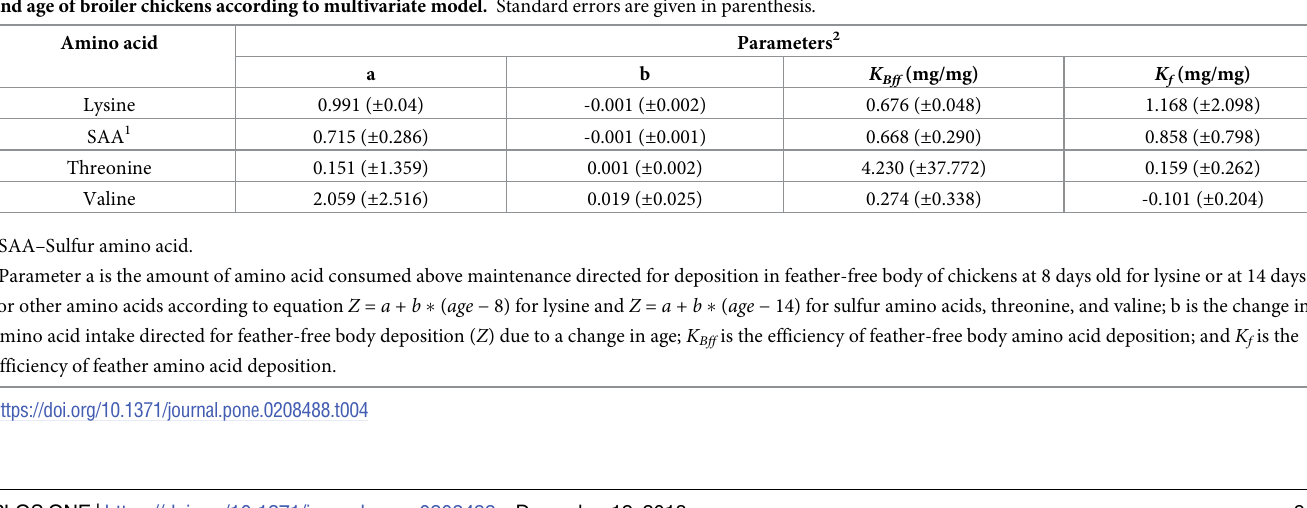
for Thr and Val (Table 5). Table 4. Parameter estimates for describing each amino acid deposition in growing broilers as a function of intake of amino acid above maintenance (mg/bird/day) and age of broiler chickens according to multivariate model. Standard errors are given in parenthesis. Amino acid